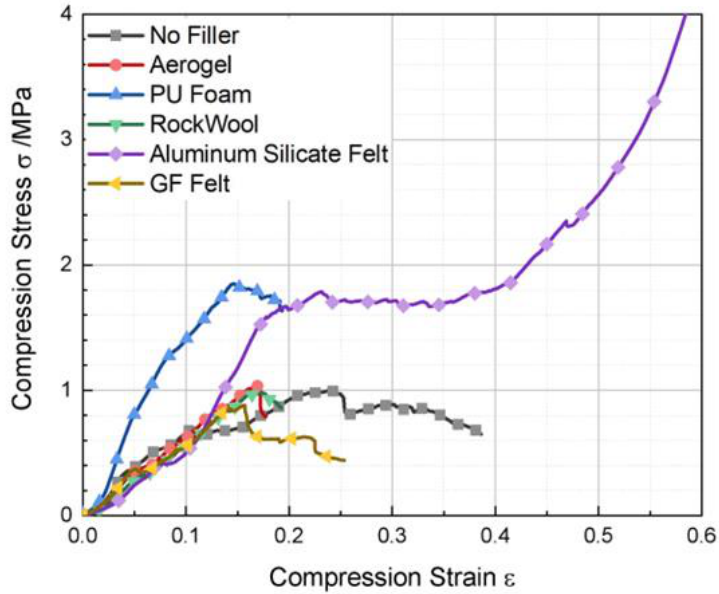
Figure 6. Different filling material corrugated sandwich plate flat pressure stress-strain curve.